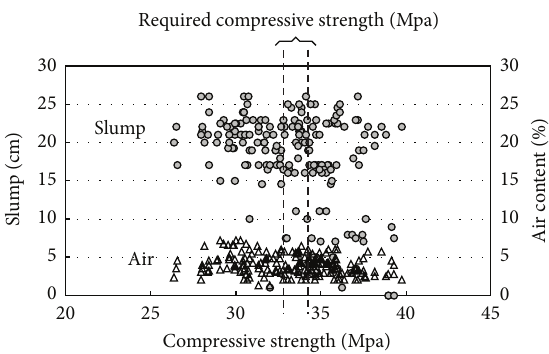
Figure 10: Range of slump and air